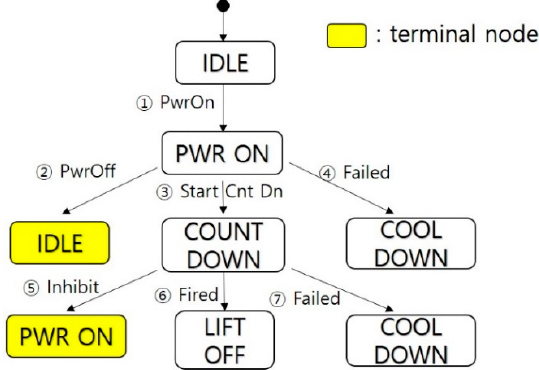
Table 1. Test suite by W method. Figure 3. Tree of the sample system by W Figure 3. Tree of the sample system by W method.